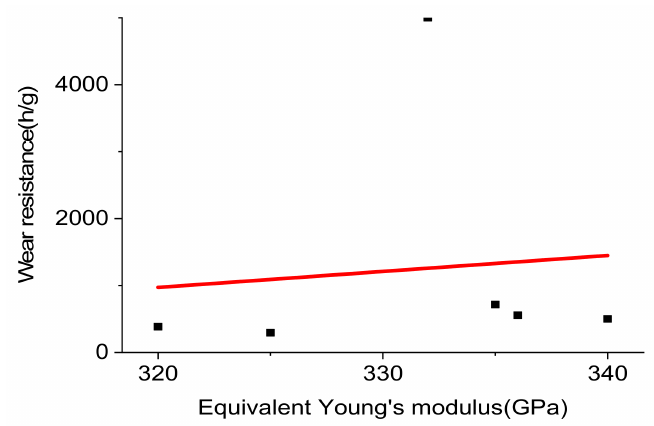
Figure 21. Influence of modulus on wear